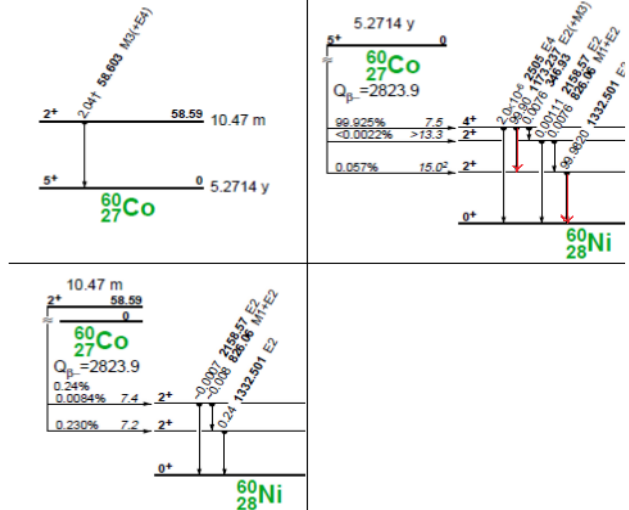
Fig. 8. The decay schemes of cobalt ground and isomer states [8].